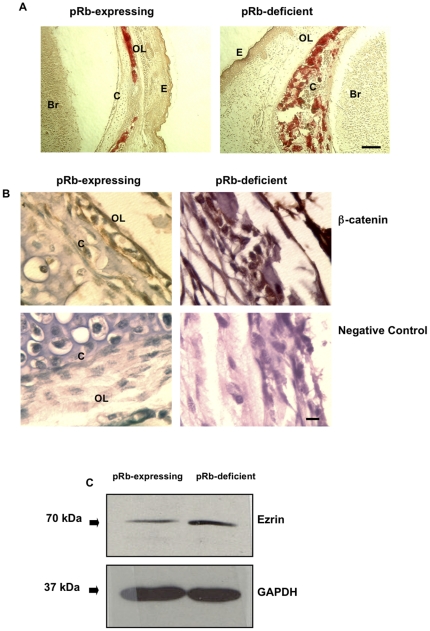
Osteoblasts in the calvarial bone of conditional pRb knockout mice show abnormal β-catenin staining.(A) Coronal skull sections of embryonic day 18.5 (E18.5) mice stained with alizarin red-S showing location of differentiated osteoblasts. In calvarial bones from pRb-expressing mice (left), osteoblasts form a layer lining the cartilage at the base of the skull, while in pRb knockout mice (right) scattered calcified nodules are found within a grossly disorganized cartilage. Magnification = ×4. Bar = 2 µm. (B) β-Catenin immunohistochemistry of calvarial bones of pRb-expressing and pRb knockout mice. Osteoblasts in calvarial bones from pRb-expressing mice show membrane β-catenin (top left). Clusters of cells showing strong nuclear immunoreactivity for β-catenin were found within the disorganized cartilage in pRb knockout mice (top right). Negative controls processed without primary antibody are shown (bottom). OL, osteoblast layer; E, epithelium; C, cartilage; Br, brain. Magnification = ×100. Bar = 1 µm. (c) A representative immunoblot showing increased ezrin expression in cultured pRb-deficient osteoblasts relative to pRb-expressing controls.